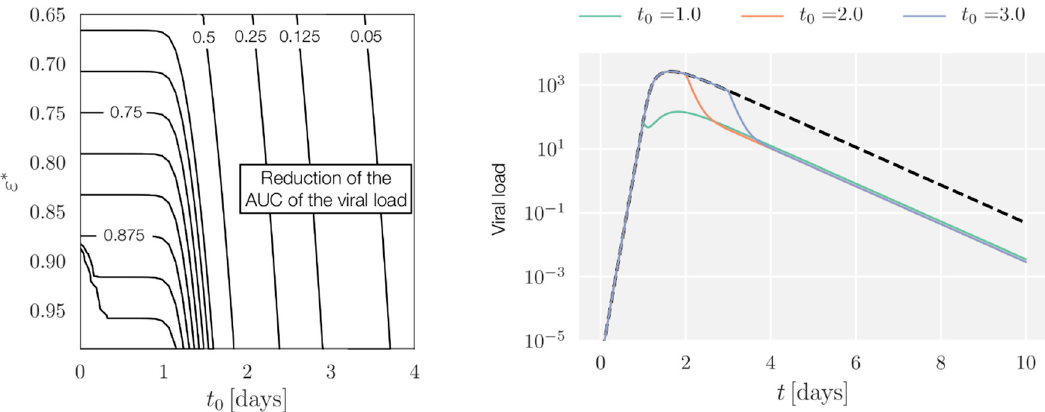
Figure A1. Left: Contour lines show the fraction of reduction in the area under the curve (AUC) of the viral load dynamics as a function of treatment initiation times and peak drug efficacy. Right: Dynamics of the within-host system in the case without treatment (black, dashed lines) and in the case with treatment for ε * = 0.95 and different therapy starting times (colored lines). To avoid artificial growth of the virus late after infection, simulations with a viral load below a prescribed tolerance–in this case, 10 − 3 TCID50 mL − 1 –one-day post-infection are assumed to have stopped growing. In all cases, the treatment corresponds to the curative regimen for oseltamivir: D 0 = 75 mg, τ = 0.5 days.